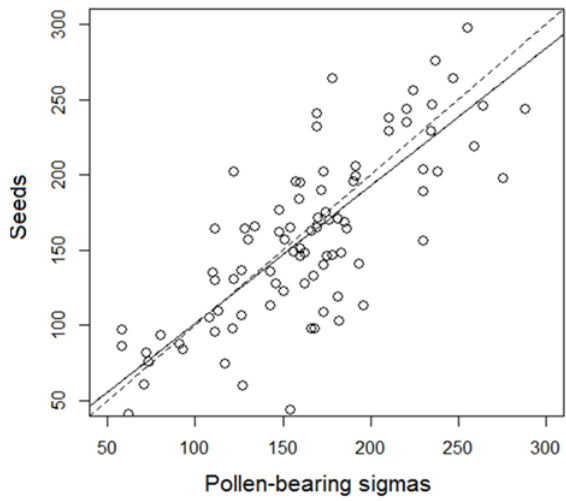
Figure 6. The relationship between number of seeds per flower and number of pollen-bearing stigmas as calculated by stigmagraphs for commercial strawberries (Fragaria × ananassa). The OLS regression line (solid) has slope = 0.92 ± 0.15, i.e. not significantly different from 1, and intercept = 9.25 ± 26.2, i.e. not significantly different from 0. The dotted line is the 1:1 line. N = 95 flowers; R 2 =